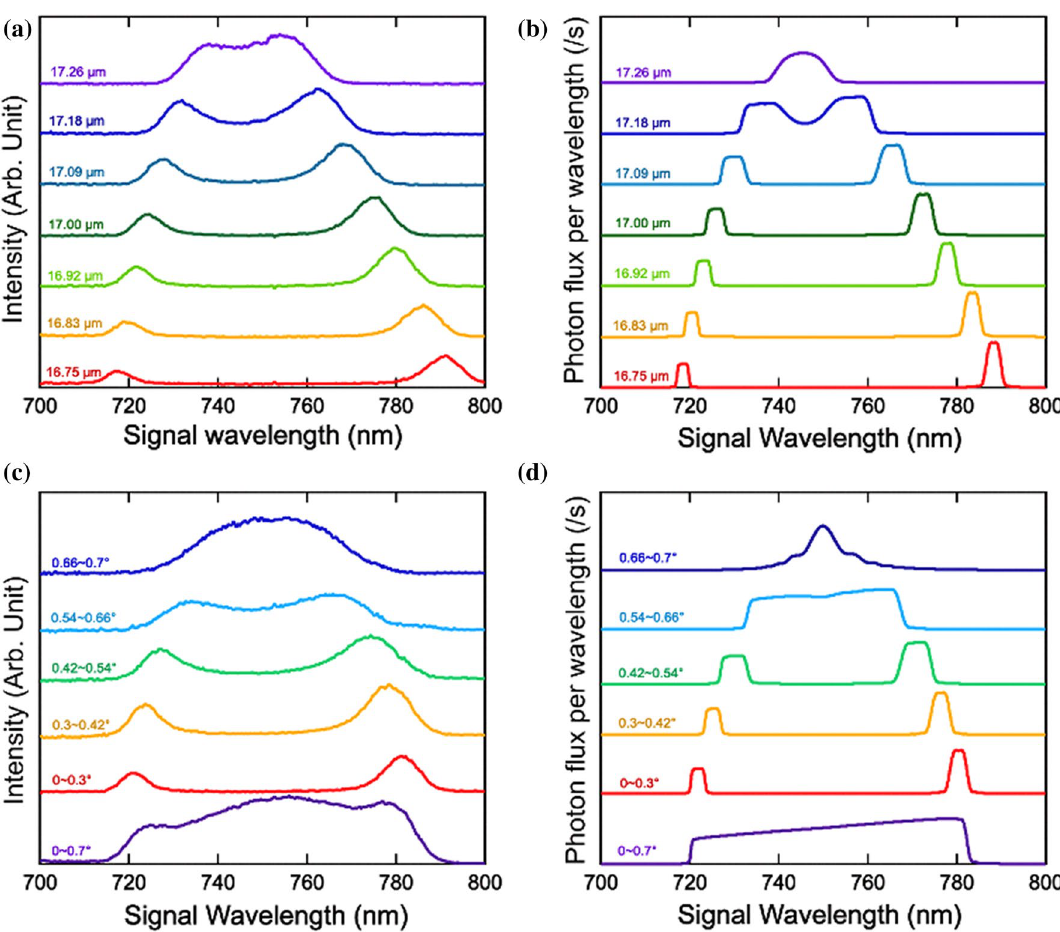
Figure 5. ( a ) SPDC signal spectra for Fanout-PPSLT with several periodicities in the collinear geometry. The two peaks correspond to phase-matched wavelengths. ( b ) Simulated collinear spectra for the periodicities measured in ( a ). ( c ) SPDC signal spectra for different emitted angles with a periodicity of 16.88 µm. The bottom broadband spectrum (0°–0.7°) includes all non-collinear components. ( d ) Simulated non-collinear spectra for the angles measured in ( c